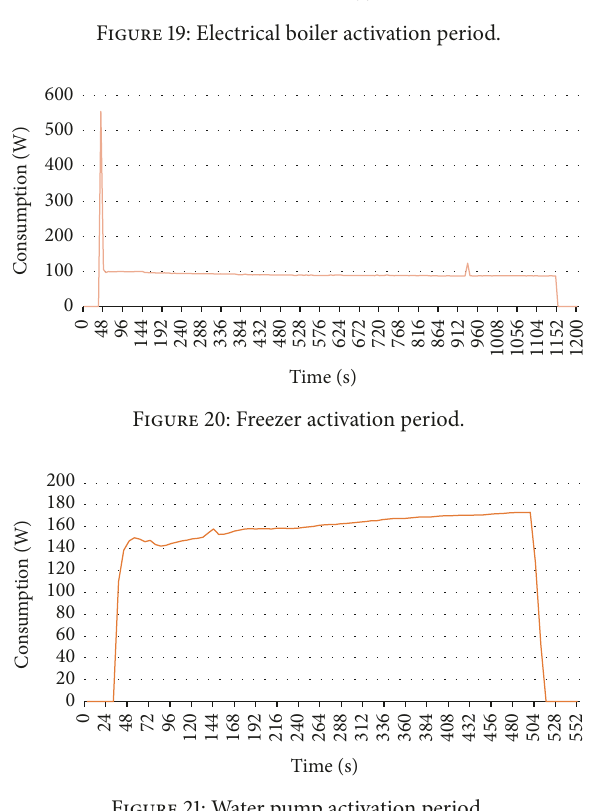
Figure 21: Water pump activation